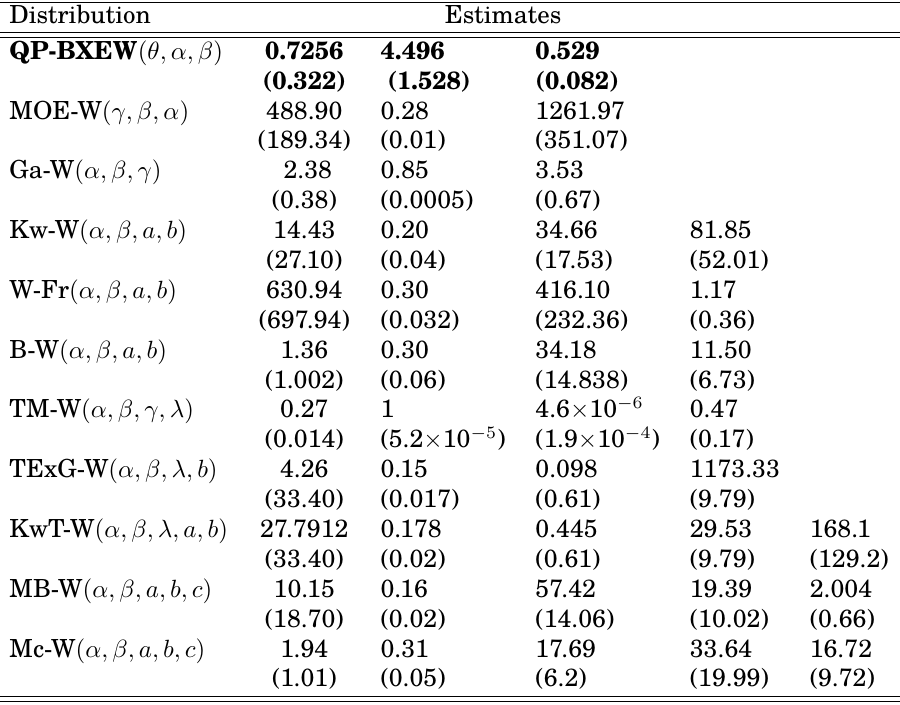
Table 2: MLEs and SEs for failure times